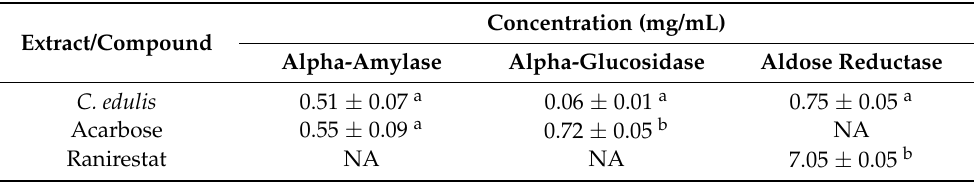
Table 2. Inhibitory effect of phenolic extract of Carpobrotus edulis on carbohydrate metabolizing enzymes and aldose